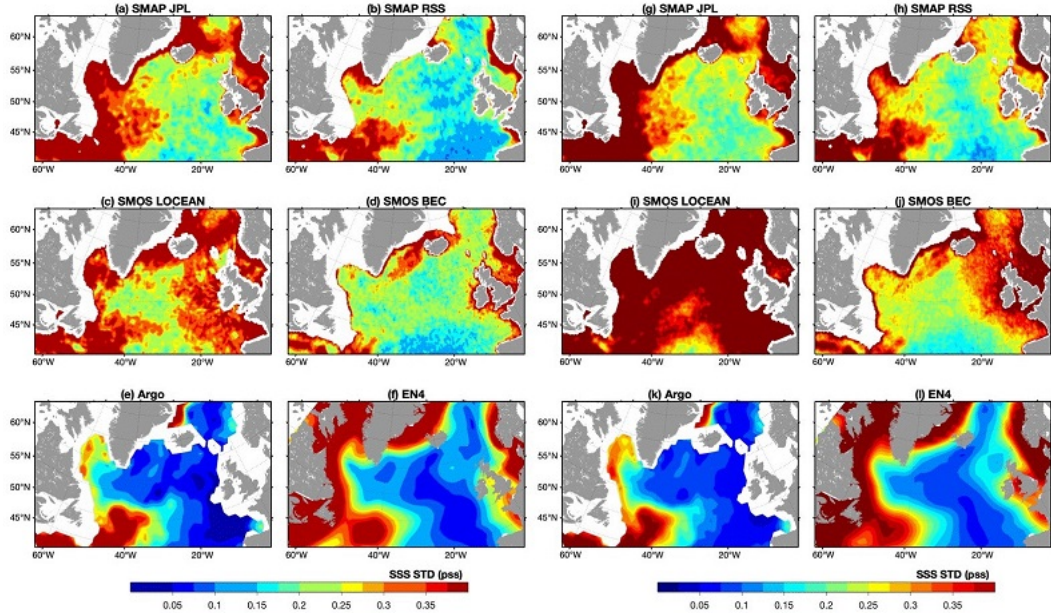
Figure 4. The standard deviation with respect to the time ‐ mean SSS for the period of 2016–2018 in ( a )– ( f ), for the SMAP period from May 2015 to December 2019 in ( g )–( h ), and for the SMOS period from January 2011 to December 2019 in ( i )–( l ). The product name is listed at the top of each